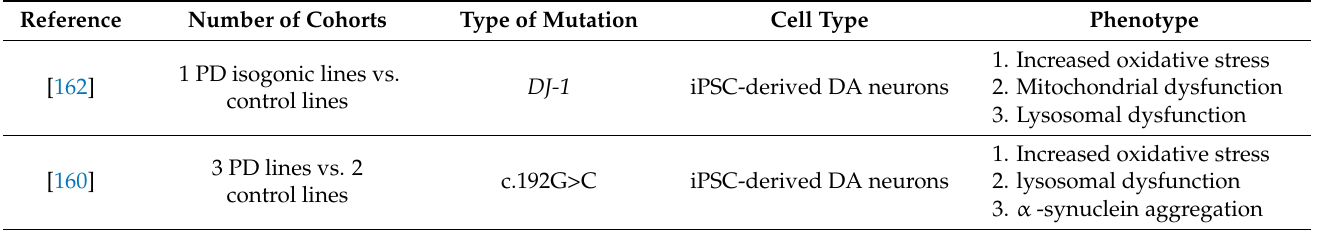
Table 6. DJ-1 -mutated iPSC-derived neuronal